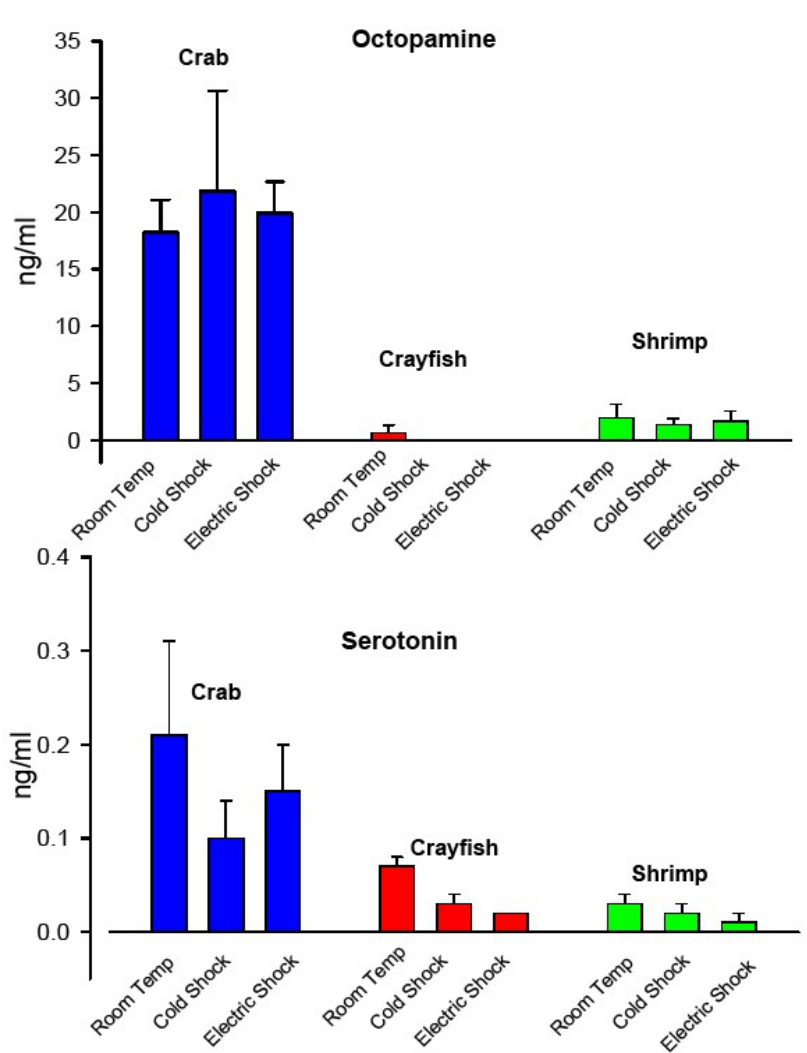
Figure 9. The quantification of octopamine and serotonin in the hemolymph of crab, crayfish, and shrimp at holding temperature and with immersion in ice slurry or after electric stunning. Measures were made with HPLC analysis after being immersed in an ice slurry for 5 min or after electric stunning for 10 s (120 V with AC current, 20 amps). Six animals were used for each condition. A mean (+/ − SEM) value of ng/mL of hemolymph is reported for each paradigm. Statistical analysis on detectable levels for the six crayfish as compared to not being able to measure the levels with cold shock and electric stunning for crayfish produces a non-normal distribution but significant difference by Kruskal–Wallis test ( p = 0.01). Serotonin levels were lower for cold shock ( p = 0.028, N = 6, Holm–Sidak) and electric stunning ( p = 0.004, N = 6, Holm–Sidak) in crayfish as compared to 20 ◦ C but not for crabs and shrimp.